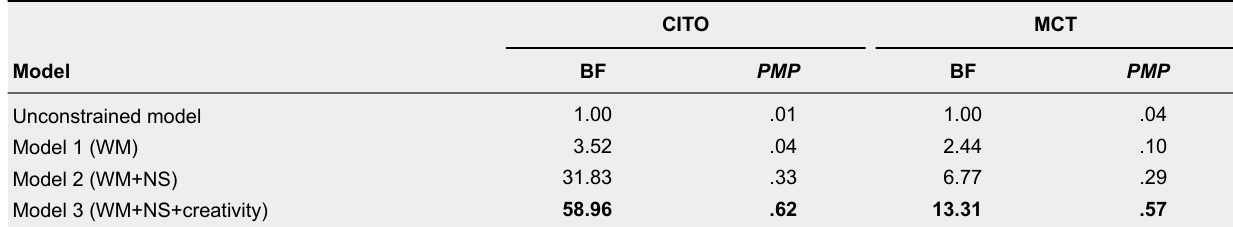
Bayesian Regression Models With IQ Included as Covariate